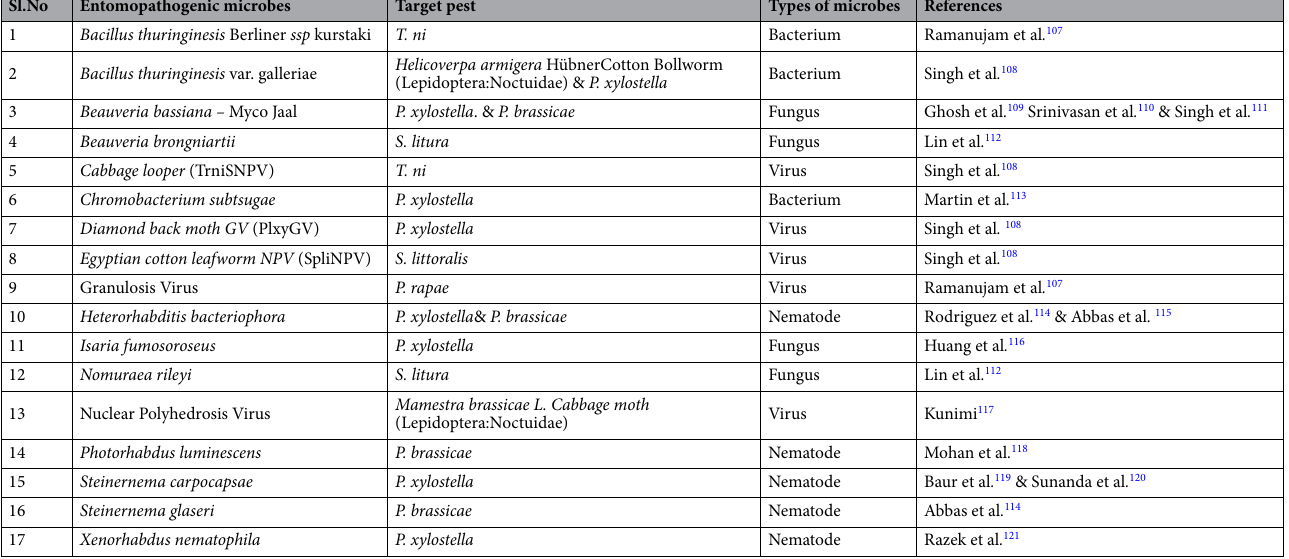
Table 2. List of some of the entomopathogenic microbes used in management of crucifer